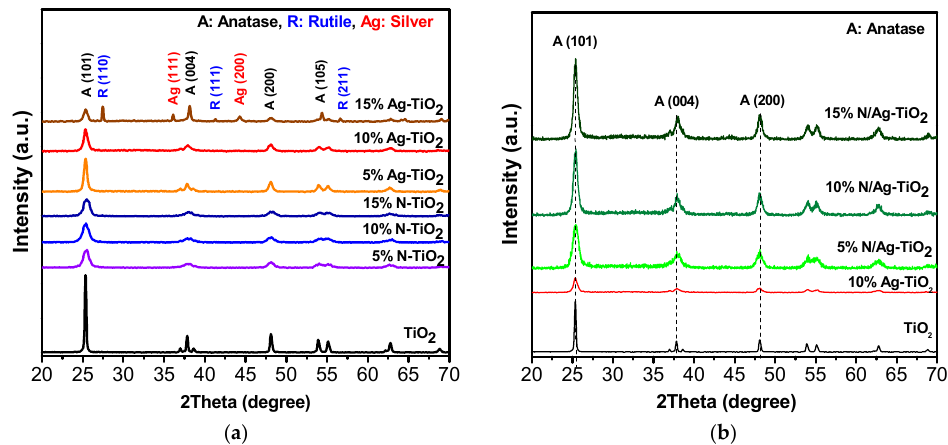
Figure 3. X -ray diffraction (XRD) spectra of ( a ) N-TiO 2 and Ag-TiO 2 and ( b ) N/Ag co-doped TiO 2 (prepared by loading N into 10% Ag-TiO 2 ) . The data for pure TiO 2 was included as a reference. (A = Anatase, R = Rutile, and Ag = Silver).